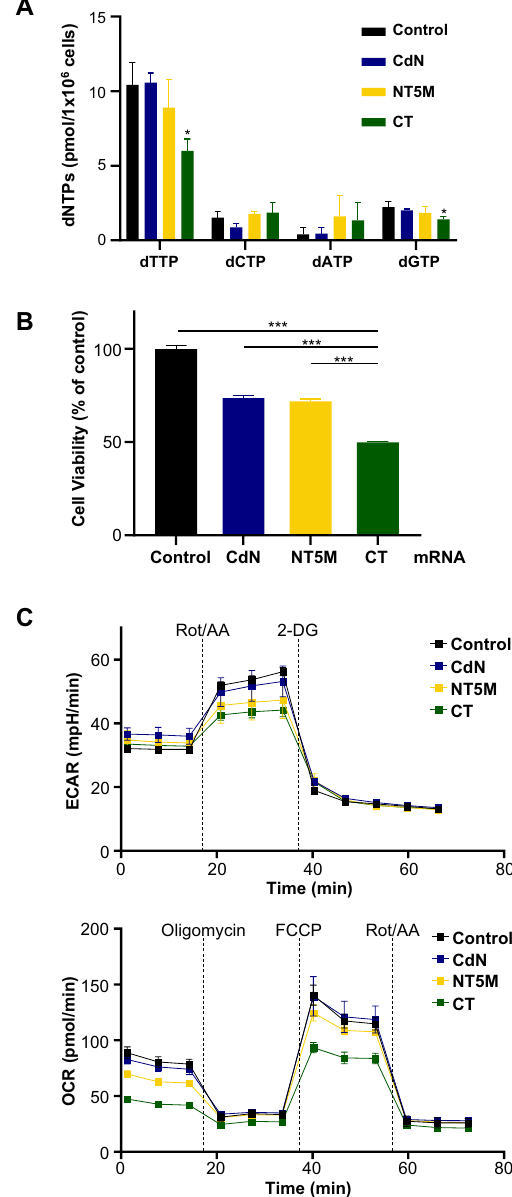
Figure 5. Cellular effects on differences of substrate preference on dTMP. ( A ) Intracellular dNTP pools with 5 ′ nucleotidases with different substrate preferences. CdN: cytosolic 5 ′ -nucleotidase; NT5M: human mitochondrial 5 ′ -nucleotidase (signal-sequence deleted). ( B ) Cell viability assay. Cells were plated 24 h in a 6-well plate at 5 × 10 5 cells/well, then transfected with 1.25 µg of mRNA for 24 h. For quantification, the amount of formazan dye formed was measured at 450 nm. ( C ) ECAR and OCR assay for comparing 5 ′ -nucleotidase substrate preferences in MDA-MB-231. ( D ) Western blot analysis for representative proteins related to cellular function. Hexokinase (HK1/2) in glycolysis; α-ketoglutarate dehydrogenase (OGDH) in important branching position of TCA cycle; glutamate dehydrogenase (GLUD) and glutaminase (GLS1) in glutaminolysis; thymidylate synthase (TYMS) and thymidine kinase (TK1) in essential entry position of dTTP synthesis; cleaved poly ADP-ribose polymerase (PARP) and phosphorylated H2AX (γH2AX) as apoptosis marker. Original blots are presented in Supplementary Information (Figure Raw